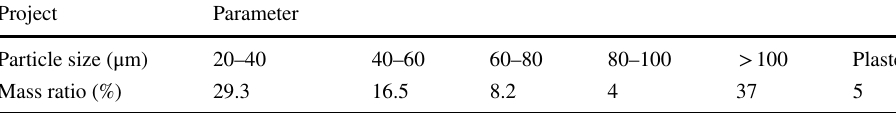
Table 3 Experimental scheme of coal and gas